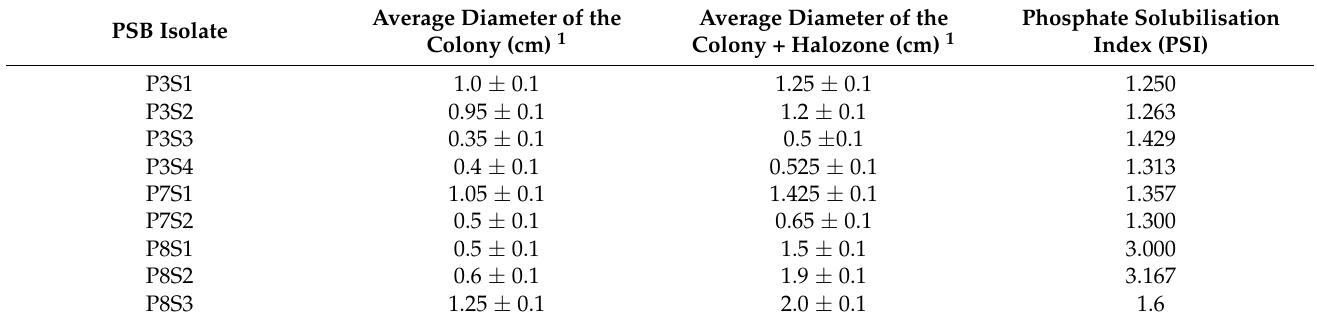
Table 1. Phosphate solubilising index of PSB isolates after 3 weeks of incubation.